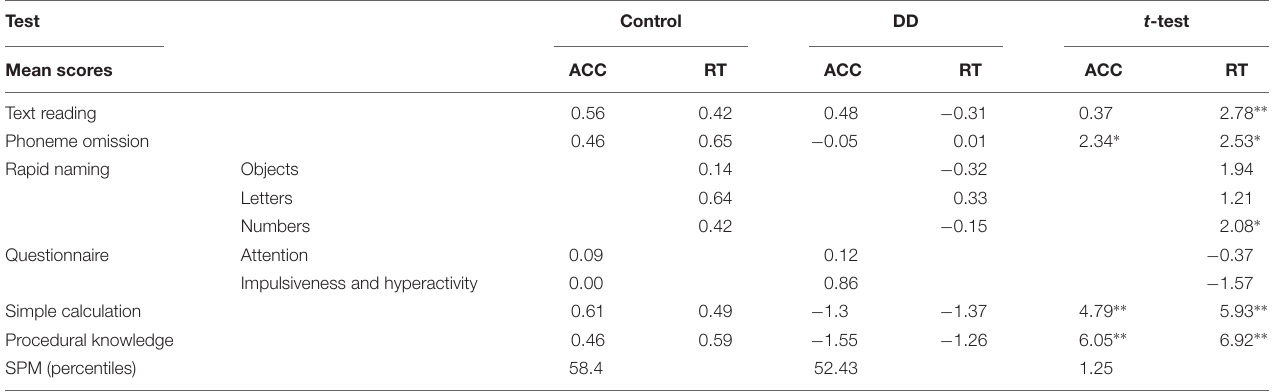
TABLE 1 | Mean standard scores and group differences in the screening tests of the two groups. Test